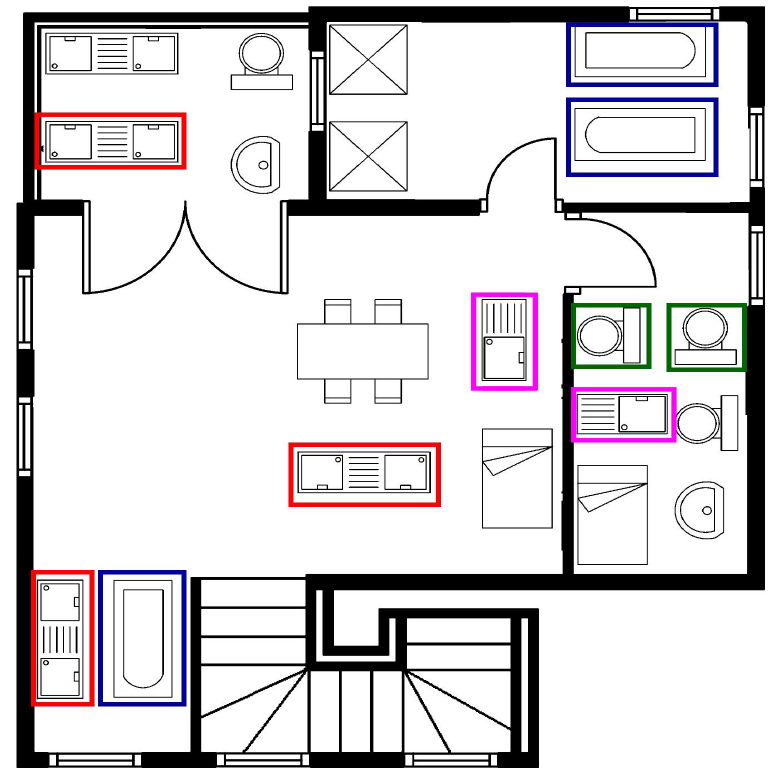
Figure 5. Sample image of the floor-plan dataset with different types of augmentation to create